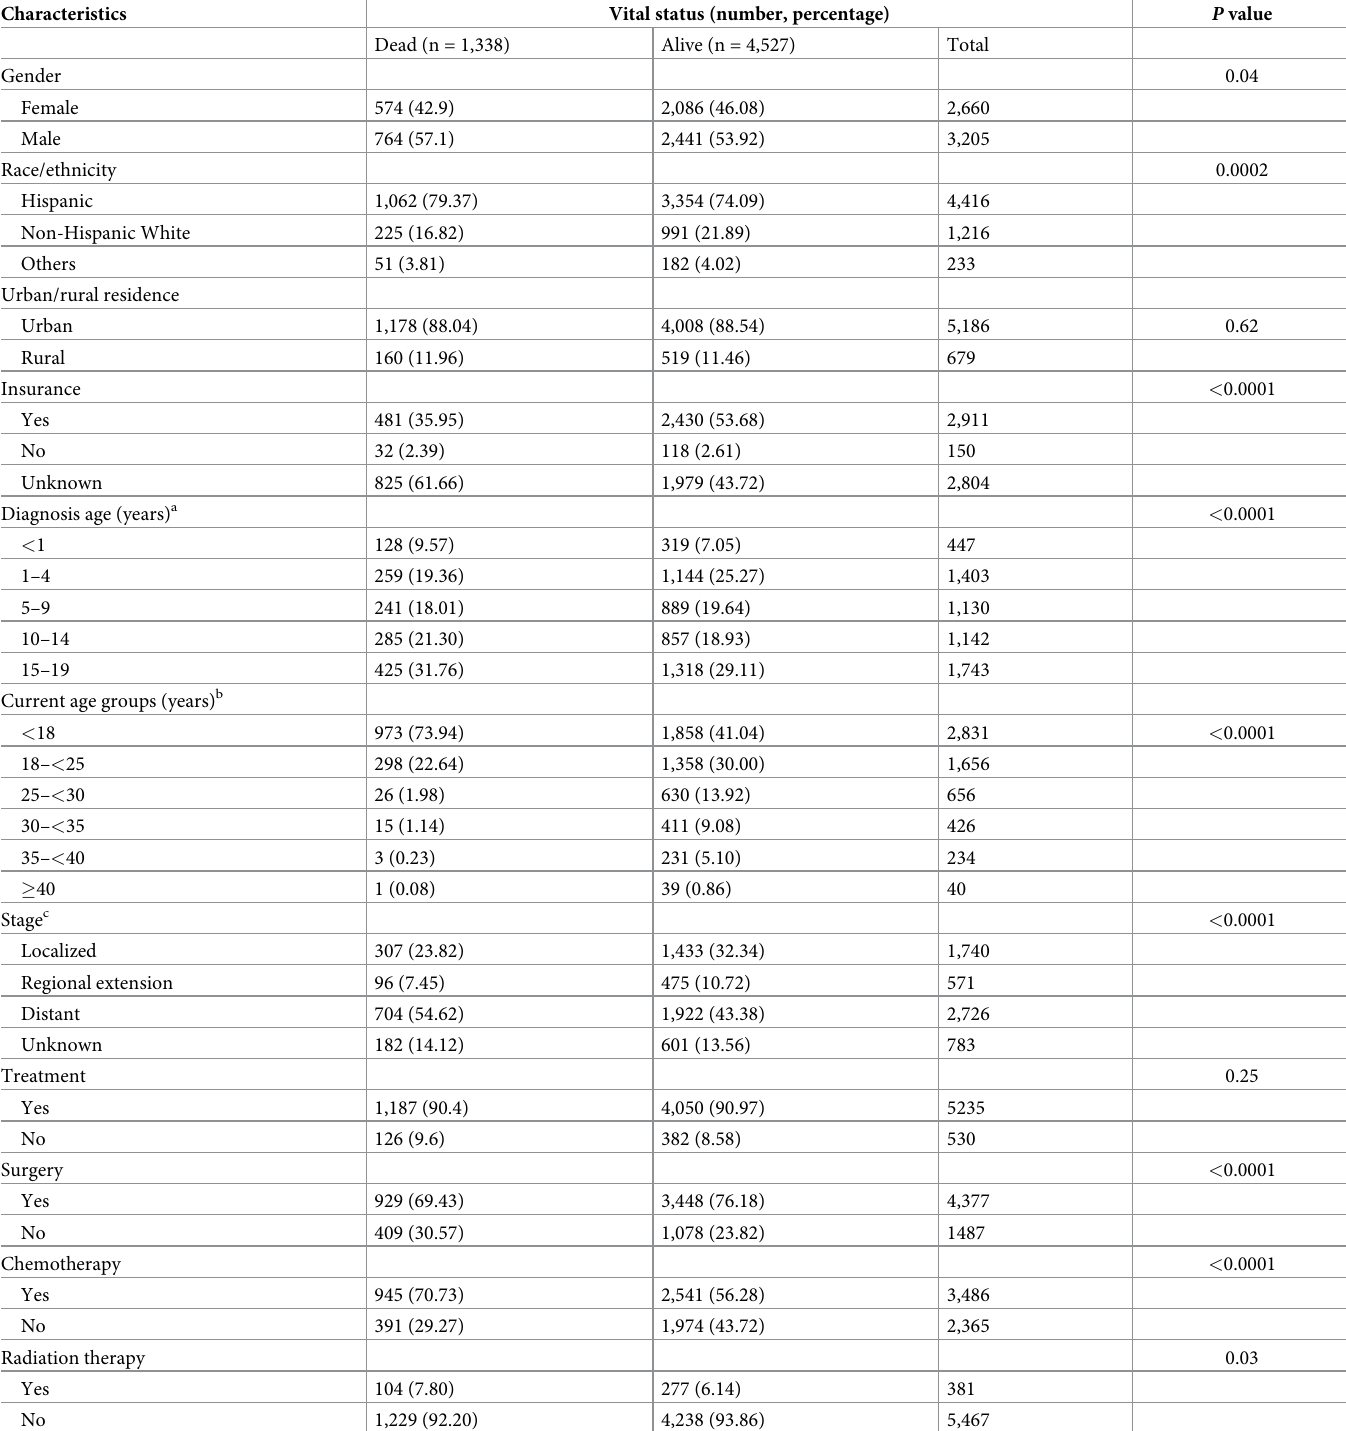
Table 2. Characteristics by the vital status among South Texas childhood cancer patients.